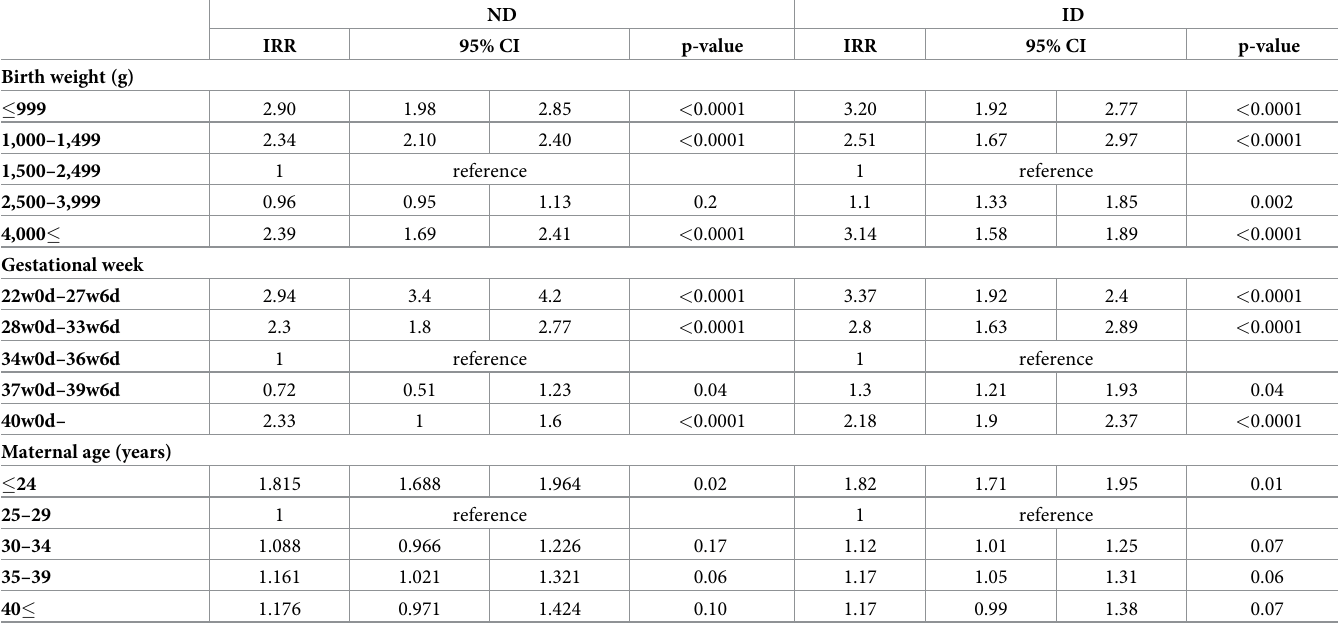
Table 8. Adjusted risks of ND and